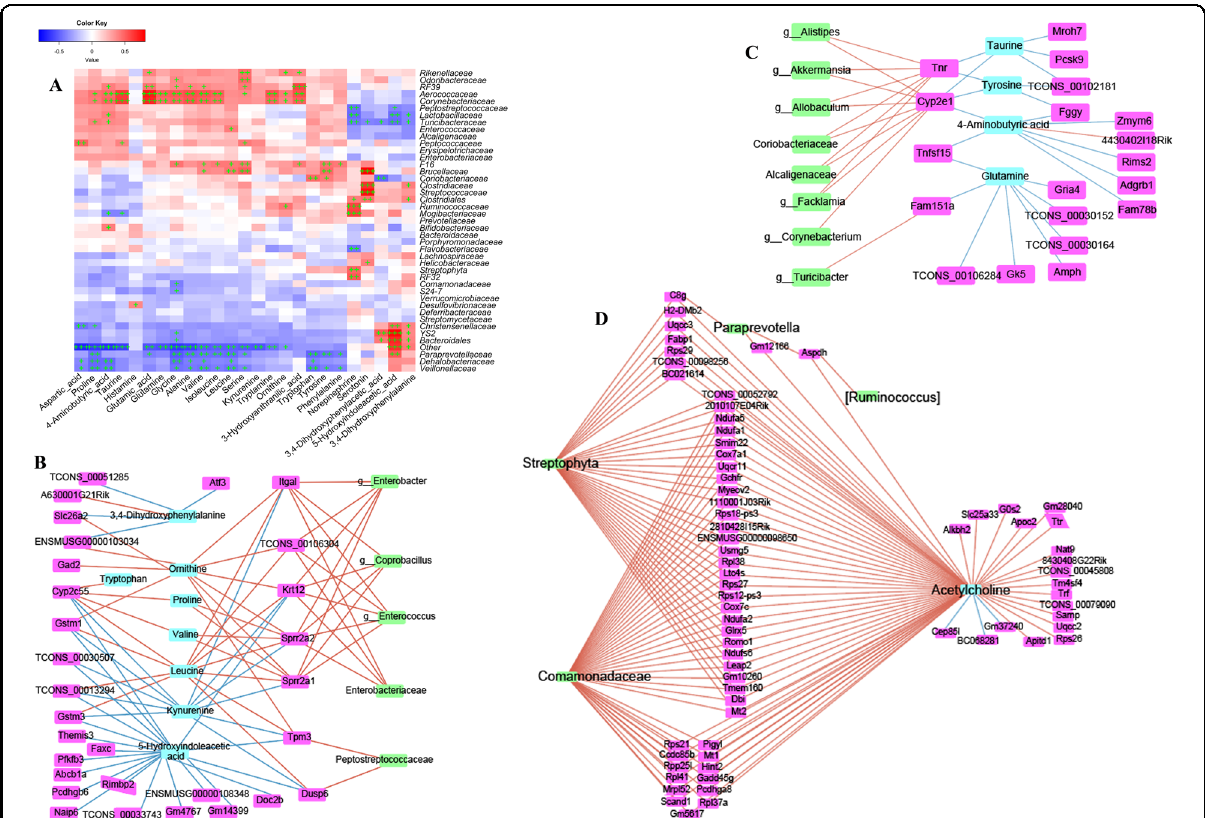
Fig. 4 Dysbacteriosis affects neurotransmitter metabolism by targeting the gut – brain axis in mice fed a diet high in sugar and fat for 4 months. A Combined data analyses between the gut microbiota (genera) and neurotransmitters in intestine tissues. B – D Combined data analyses between the gut microbiota (genera), transcriptome (mRNA) and neurotransmitters in intestine tissues. Data are the mean ±SD of more than 8 independent